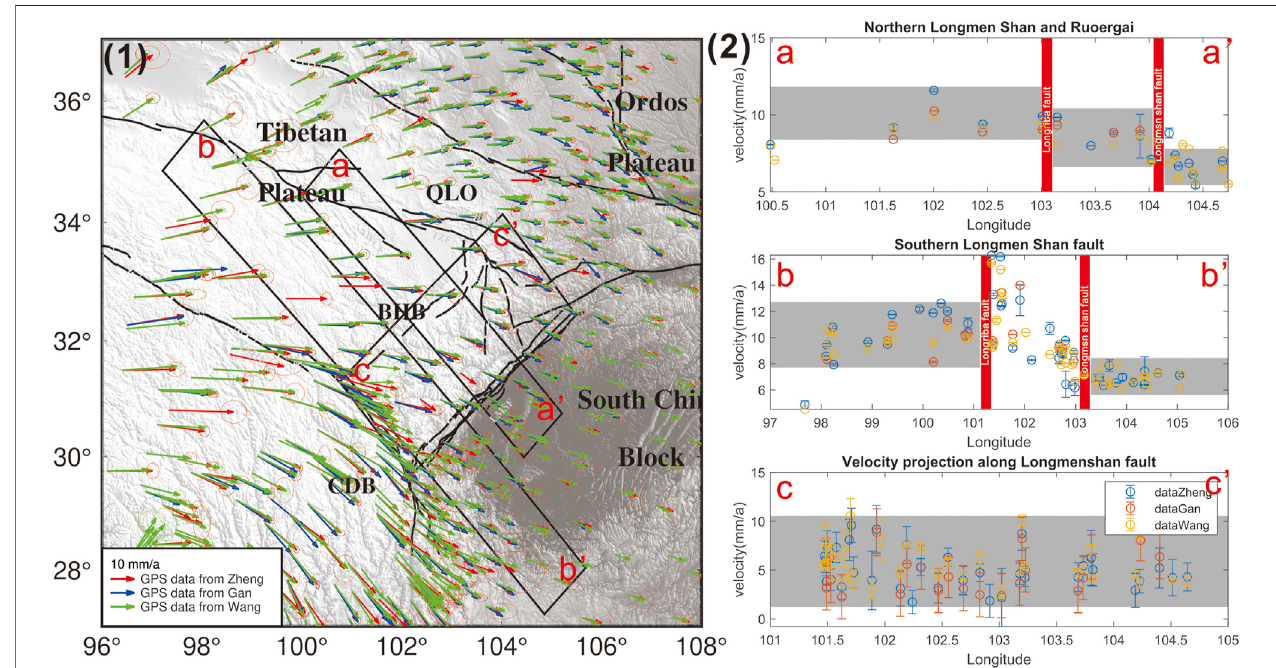
FIGURE9| AnalysisoftheGNSSextractiondata. (1) GNSSdatasetsfrom(Ganetal.,2007;Zhengetal.,2017;WangandShen,2020)visualizedinthemapand3 extraction areas based on the GNSS data. (2) Pro fi les a-a ’ , b-b ’ Extracted GNSS data within the box range and projected velocity fi eld perpendicular to the Longmen Shan fault.Pro fi le c-c ’ GPS dataare extracted within thebox, and the velocity fi eld isprojected paralleltothe Longmen Shan fault. BHB: Bayan-Har Block;QLO: Qinling Orogen; CDB: Chuandian